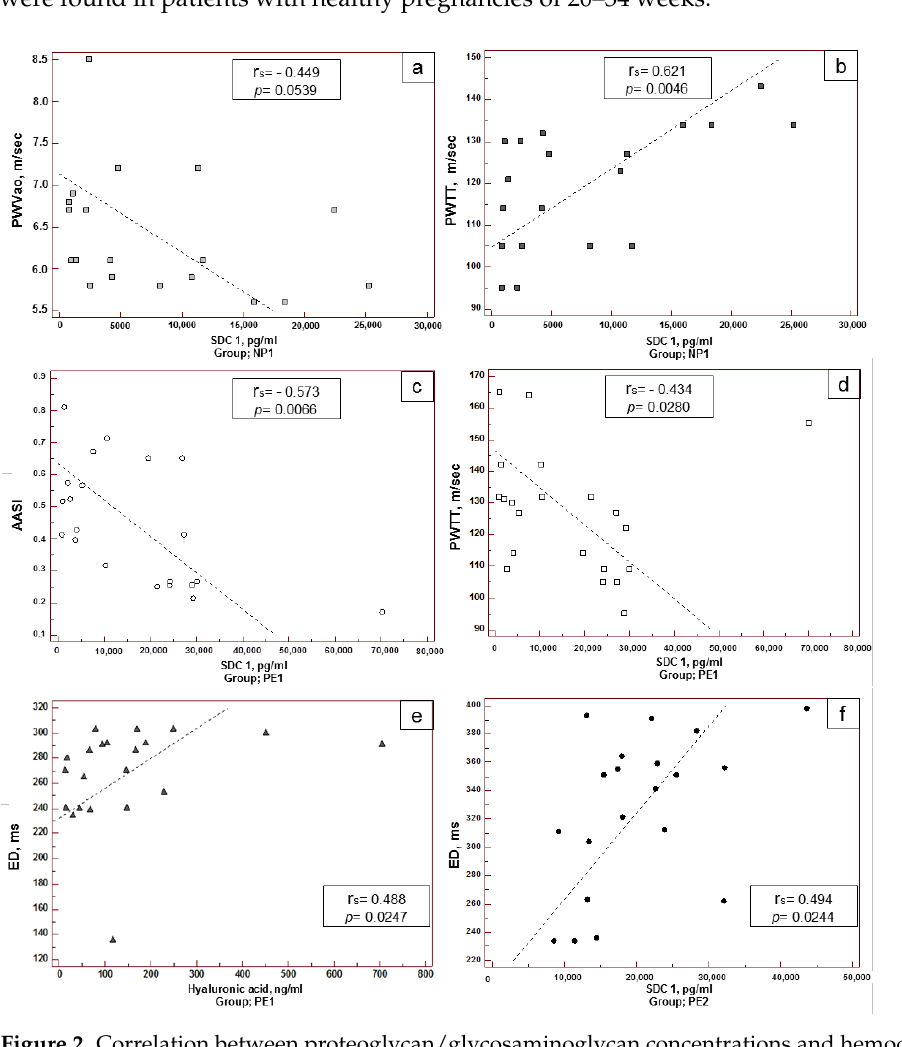
Figure 2. Correlation between proteoglycan/glycosaminoglycan concentrations and hemodynamic parameters in women: with healthy pregnancy of 20–34 weeks ( a , b ); with early-onset PE ( c – e ); with late-onset PE ( f ). Statistical analysis with Spearman